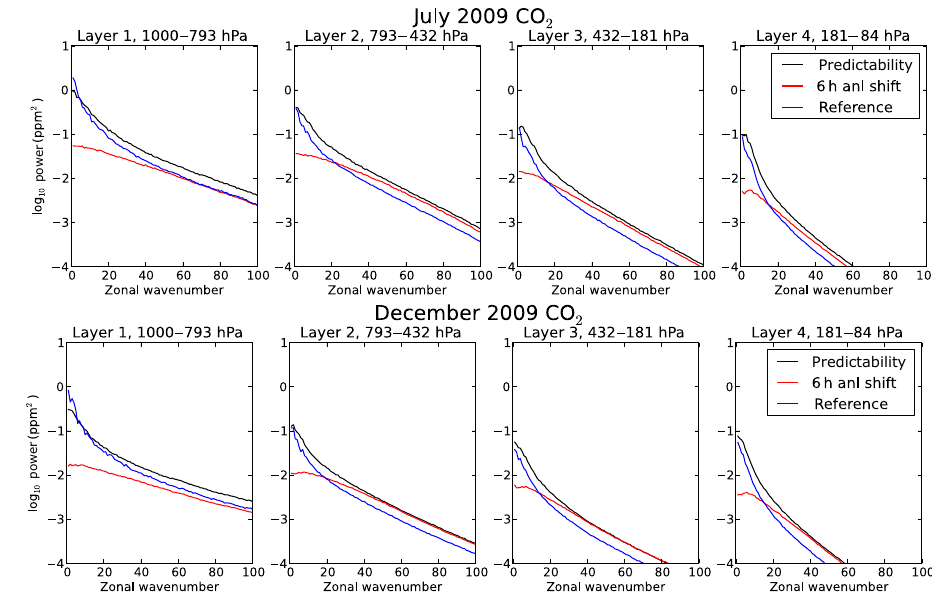
Figure 12. As in Fig. 11 but for spectra as a function of zonal